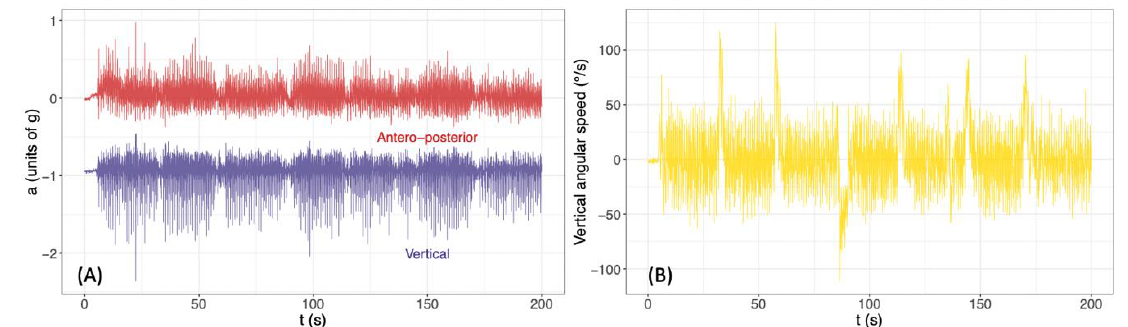
Figure 2. ( A ) Typical traces of anteroposterior ( 𝒂 𝒂𝒑 ) and vertical ( 𝒂 𝒗 ) accelerations measured by the DYSKIMOT during the six-minute walking test. ( B ) Typical trace of vertical angular speeds ( 𝝎 𝒗 ) measured by the DYSKIMOT during the six-minute walking test. The regularly spaced peaks correspond to turnarounds made by the participants.